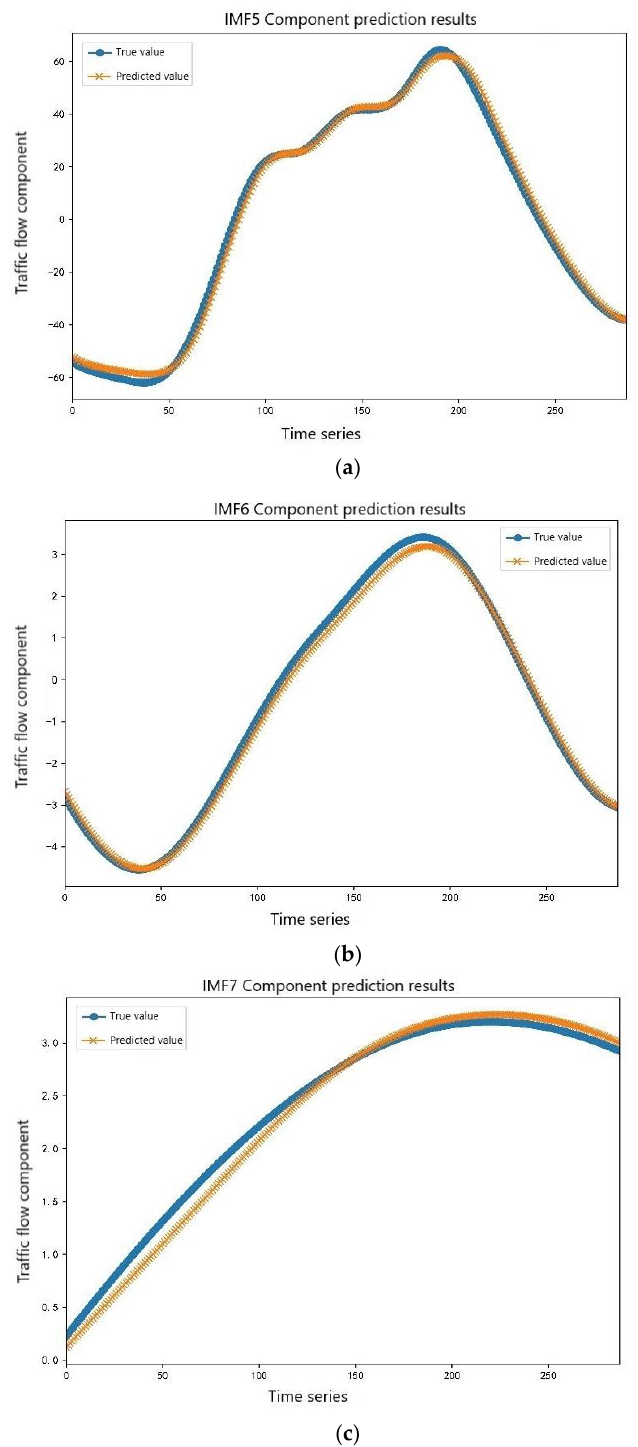
Figure 10. Prediction results of the intermediate-frequency component sequence. ( a ) IMF5 component prediction results. ( b ) IMF6 component prediction results. ( c ) IMF7 component prediction results.